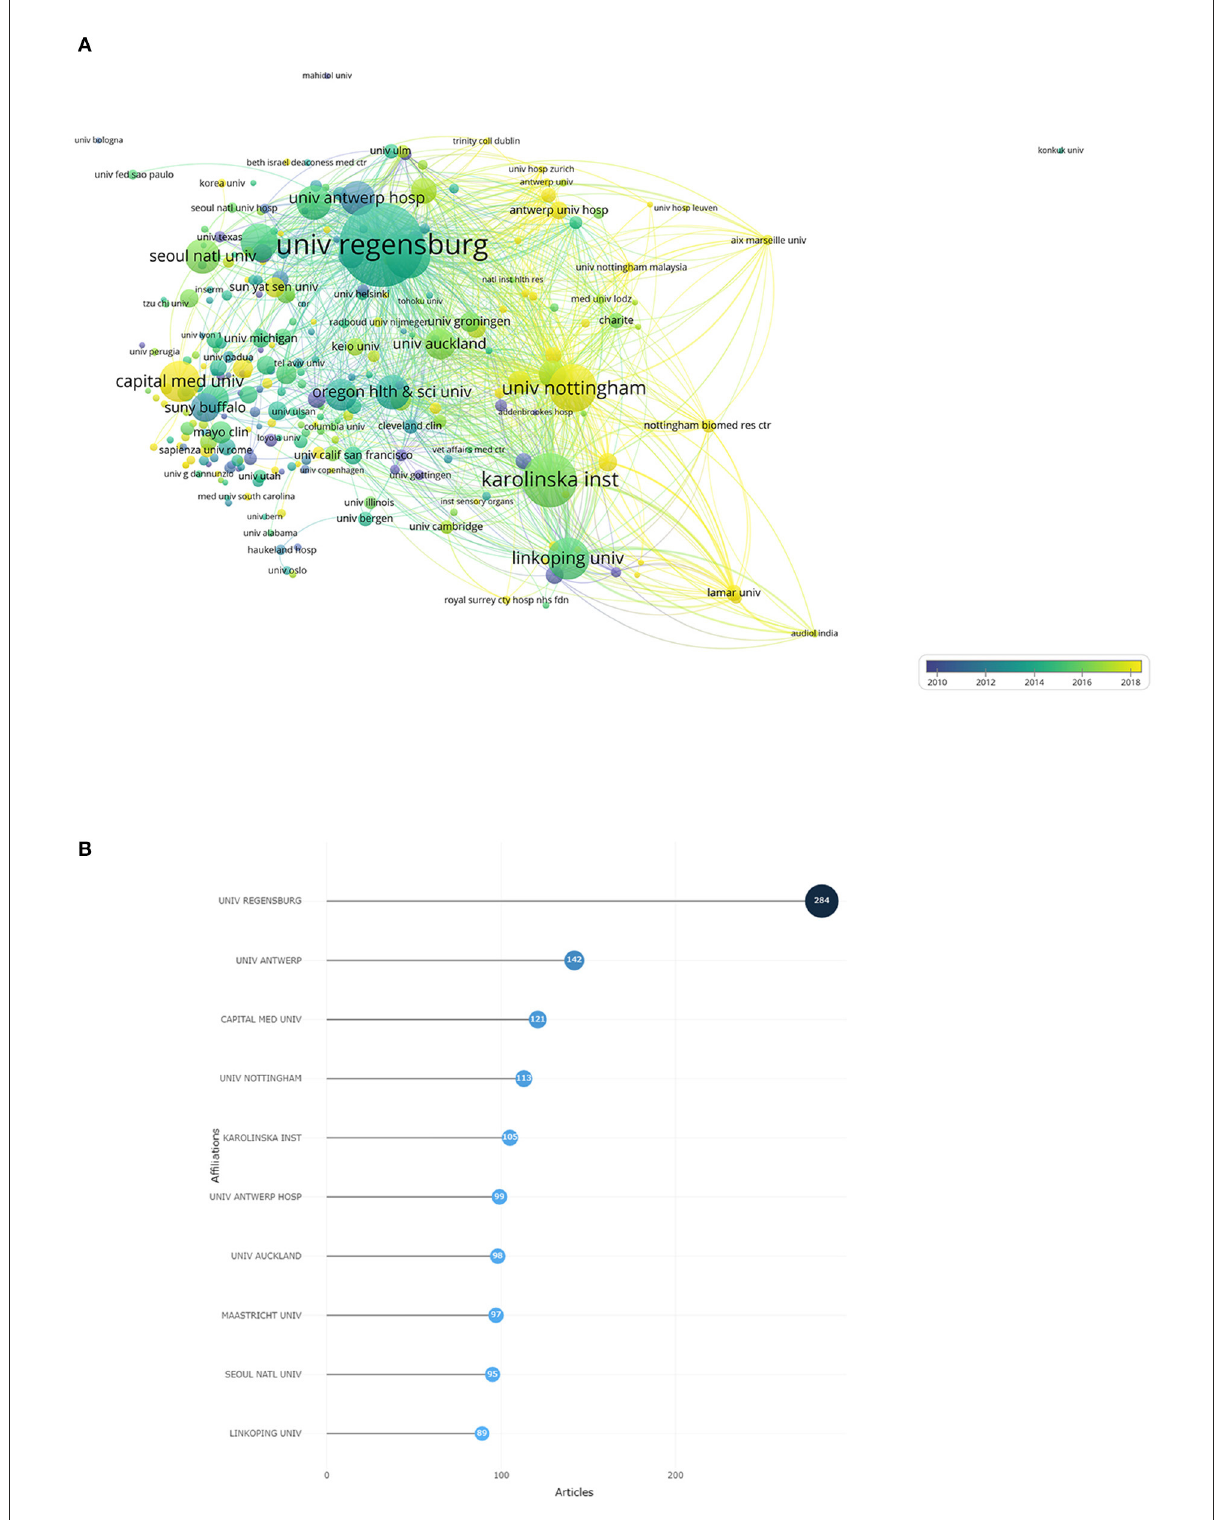
FIGURE5 (A) The font size of each institution’s name represents the number of articles in the institutions. The thickness of the curved connecting line represents the collaborative intensity between institutions; the institutions collaboration network of research on tinnitus treatment; different colors inside the circle represent different time intervals. (B) Top 10 research institutions on tinnitus